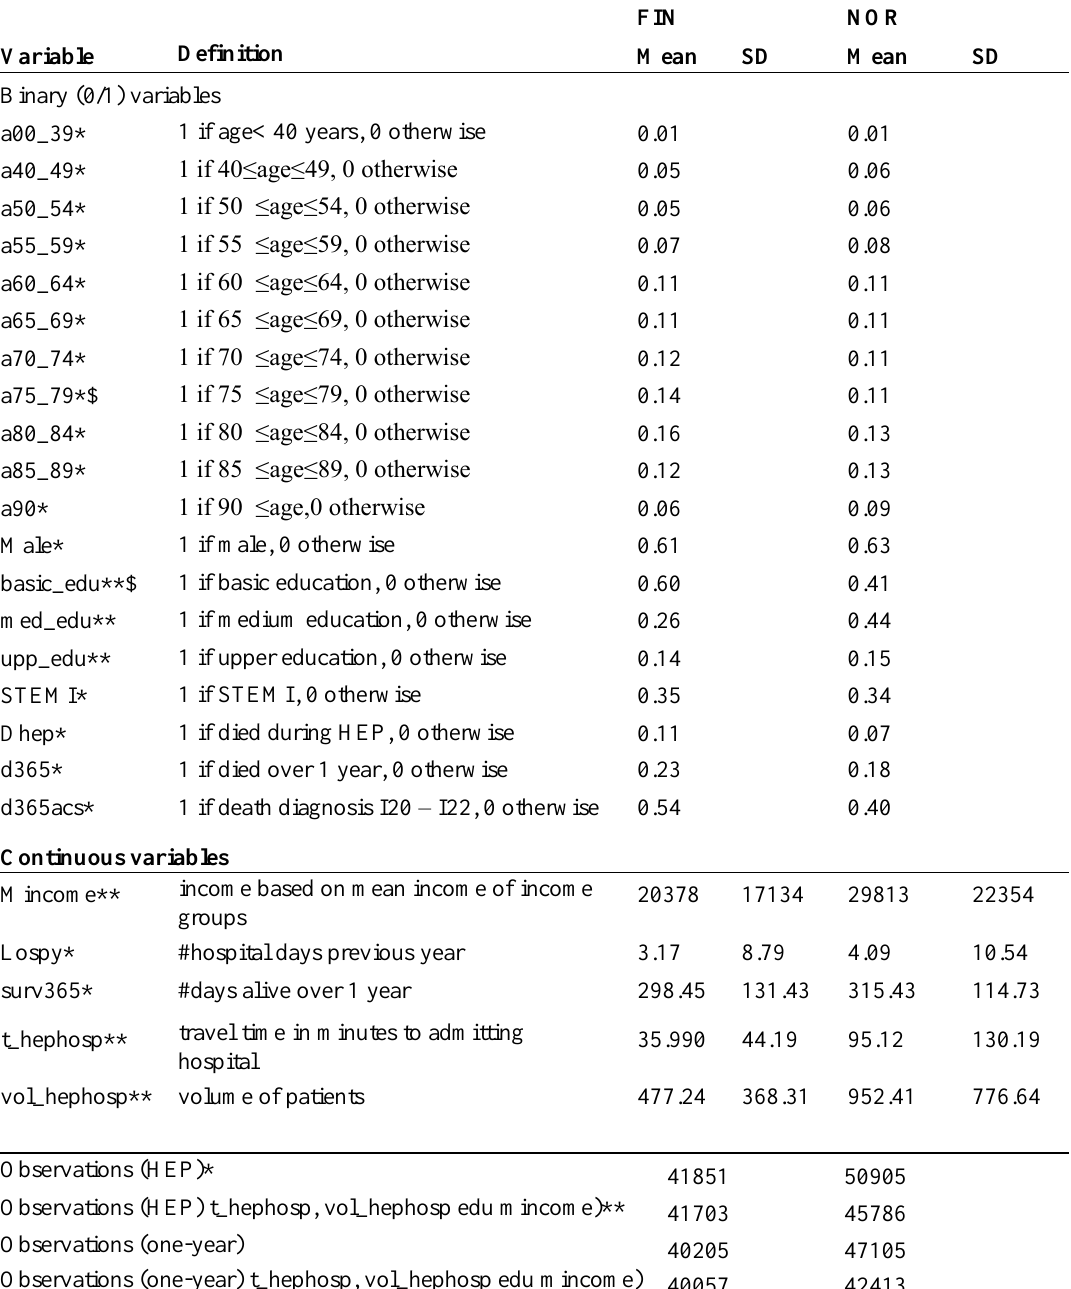
Descriptive statistics on patient composition and outcome (national comparison 2009 -